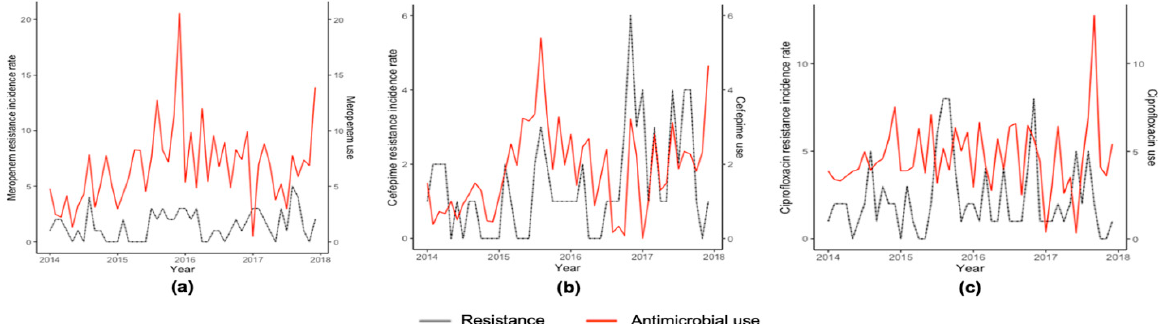
Figure 2. Smoothed monthly resistance detection rate of P. aeruginosa and hospital use of meropenem ( a ), cefepime ( b ), and ciprofloxacin ( c ).